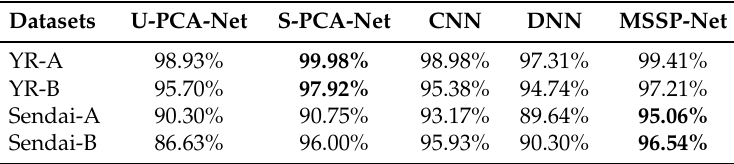
Figure 3. The visual experiment results of the compared methods: ( a ) unsupervised PCA-Net (U-PCA-Net), ( b ) supervised PCA-Net (S-PCA-Net), ( c ) CNN, ( d ) deep neural network (DNN), ( e ) MSSP-Net and ( f ) Reference map. From the above to bottom, they are the comparison results on YR-A, YR-B, Sendai-A and Sendai-B dataset, respectively. Table 2. The change detection accuracies of compared